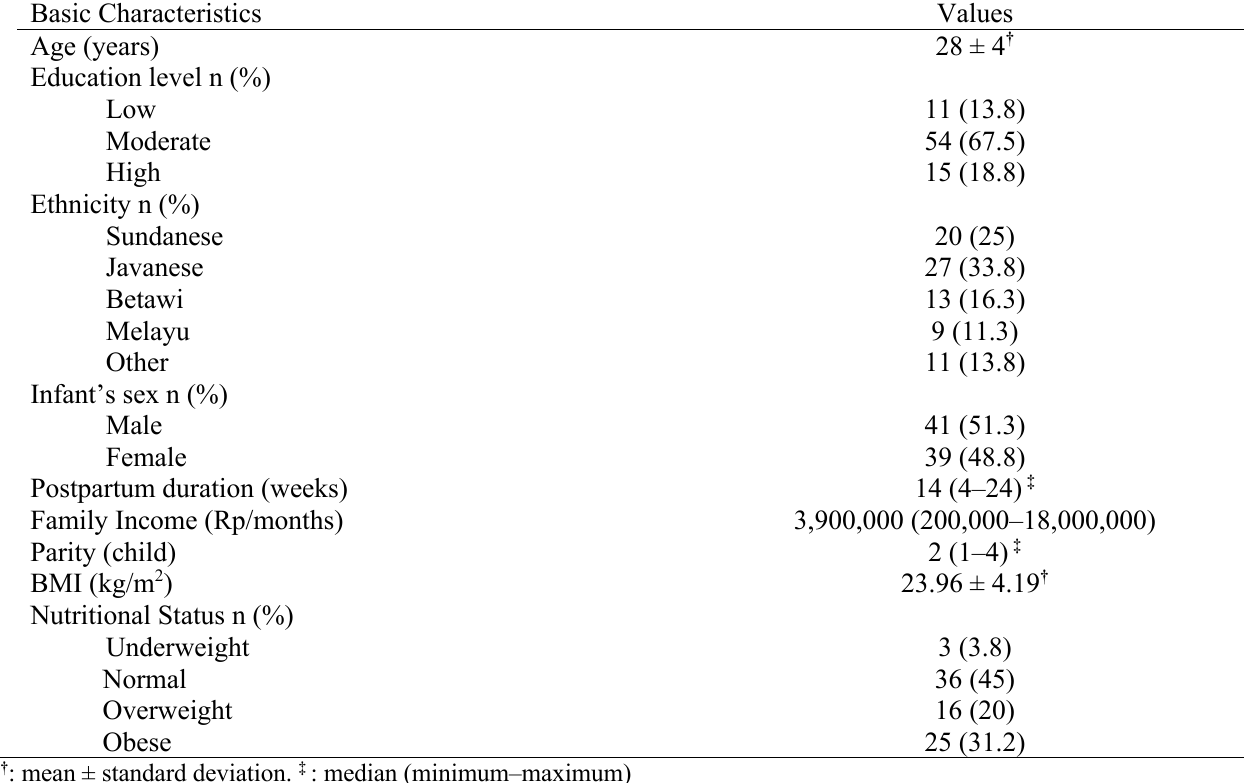
Table 1. Baseline characteristics of subjects (n=80) Basic Characteristics